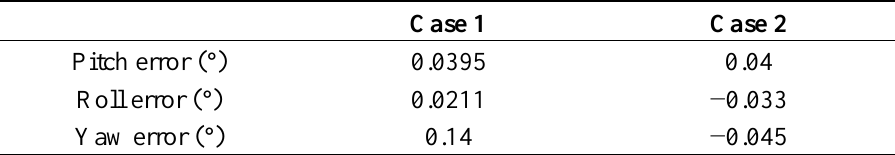
Table 12. The alignment errors in turntable test.